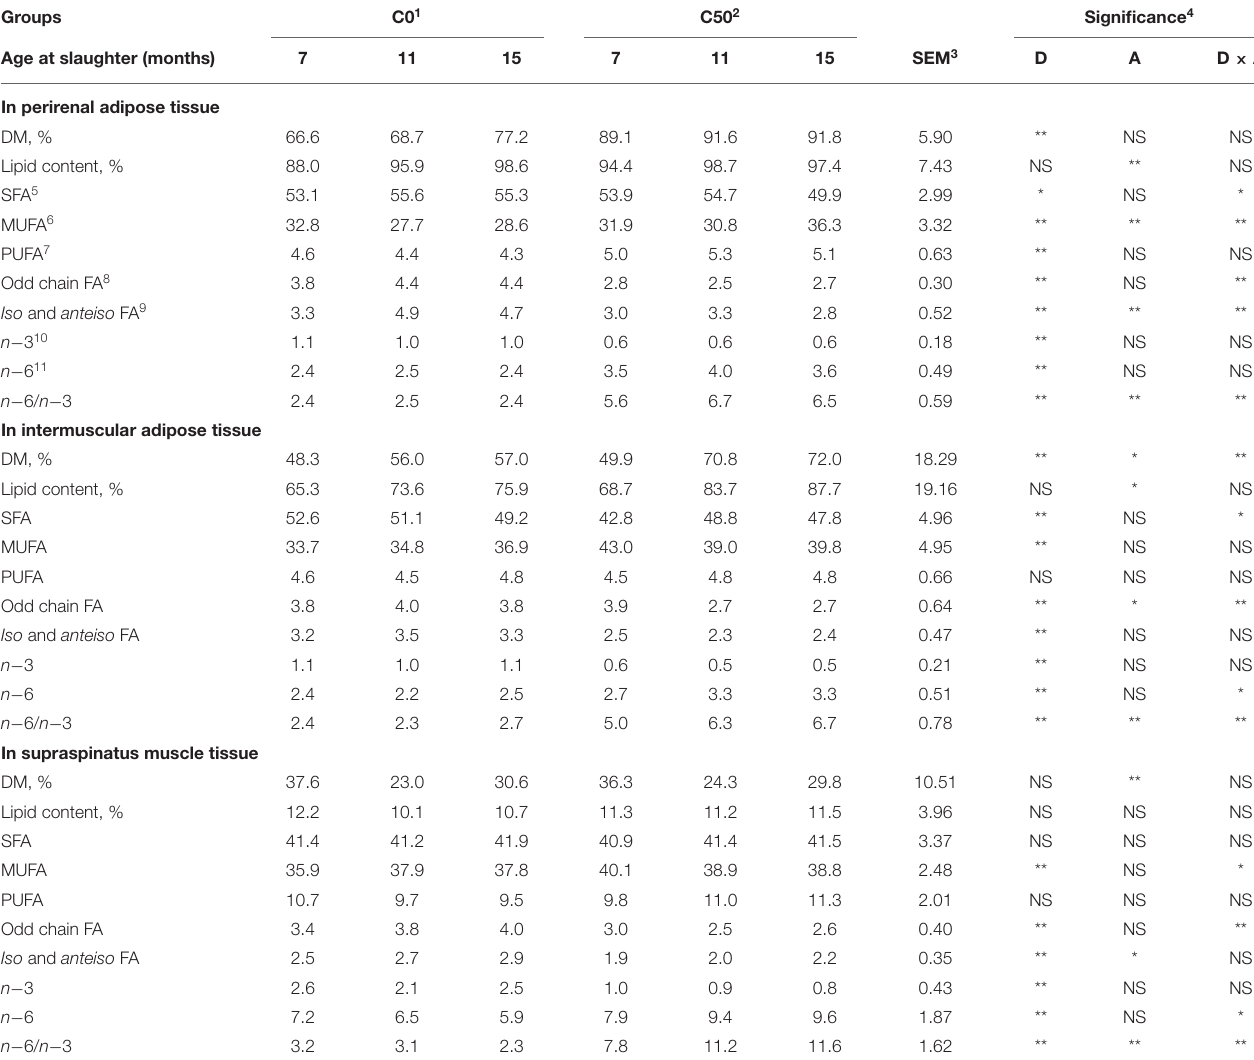
TABLE 4 | Major fatty acid (FA) proportions (g/100g of FA) in adipose tissues, perirenal and intermuscular fats, and muscle tissue of Creole goats according to diet and age at slaughter.